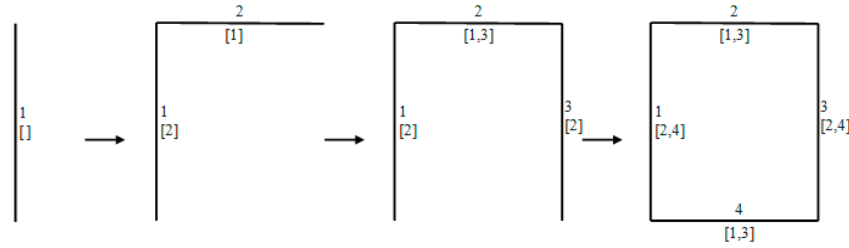
Figure 4. Example of recognition of a rectangle with the programmed automaton.